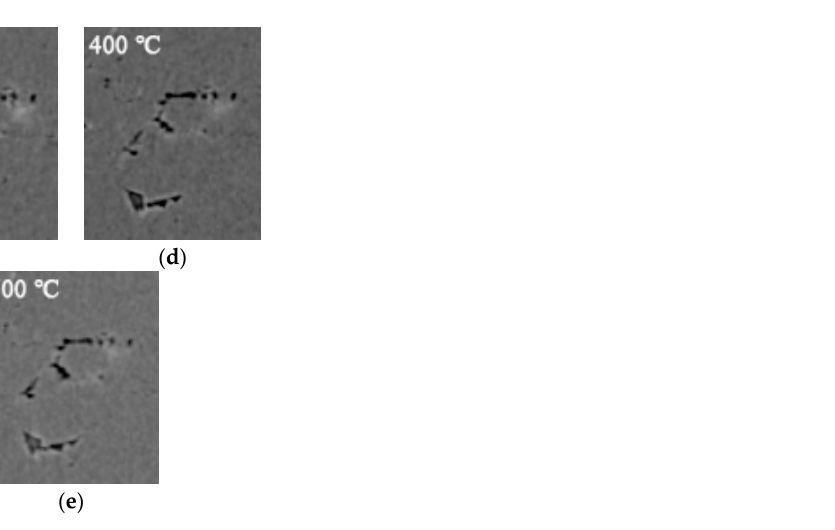
Figure 10. The CT images corresponding to the layer marked by a red square in Figure 9a–e. ( a ) 25 °C. ( b ) 200 °C. ( c ) 300 °C. ( d ) 400 °C. ( e ) 500 °C.